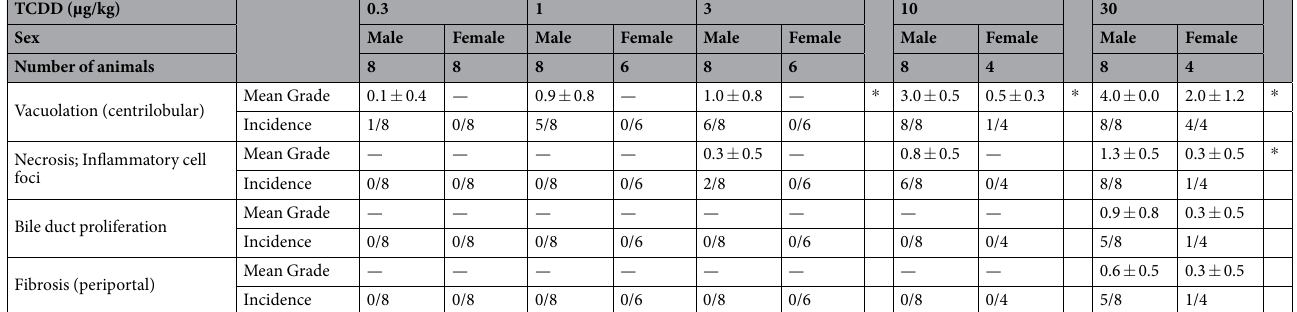
Table 1. Comparison of TCDD-elicited histopathological changes between male and female C57BL/6 mice. Histopathological grade: 0 = Within normal limits, 1 = Minimal, 2 = Slight, 3 = Moderate, 4 = Marked. No noteworthy hepatic changes were observed in mice treated with sesame oil vehicle or ≤ 0.1 µ g/kg TCDD. Mean Grade = Mean of histopathological grades ± SD. * p ≤ 0.05 (compared between males and females at the same dose,